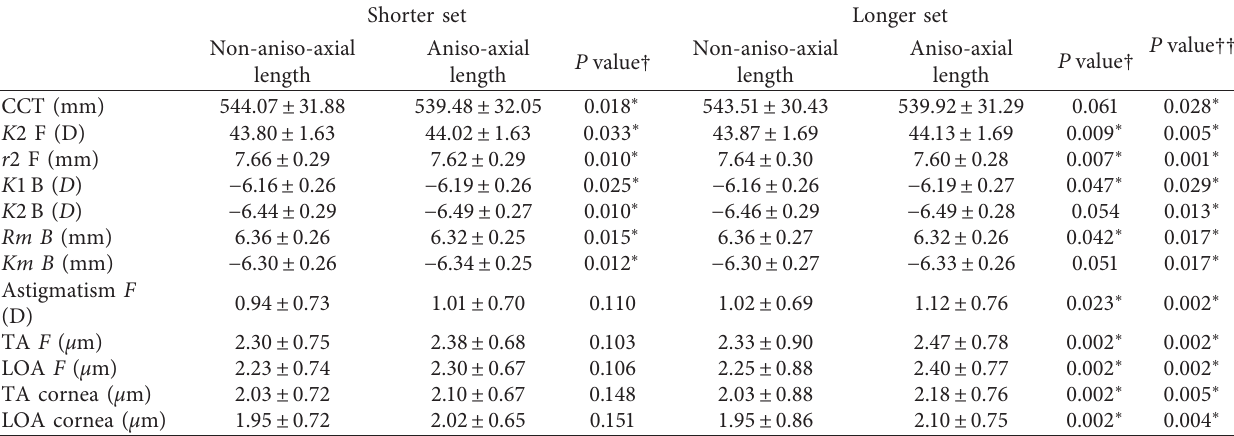
Table 2: Comparisons of corneal biometrics between non-aniso-axial length and aniso-axial length patients in both the shorter and longer sets.